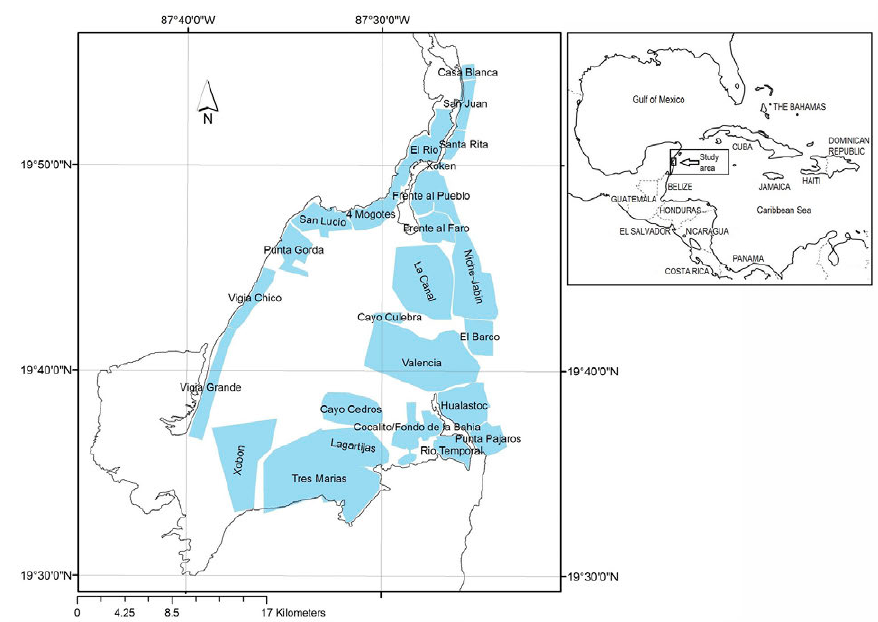
Fig. 1. – Map of Ascension Bay and the 25 spiny lobster ( Panulirus argus ) fishing areas. Insert map showing study location between the Gulf of Mexico and the Caribbean